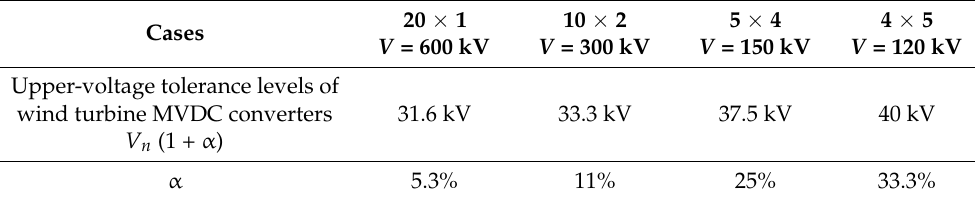
Table 2. Upper-voltage tolerance levels are specified by